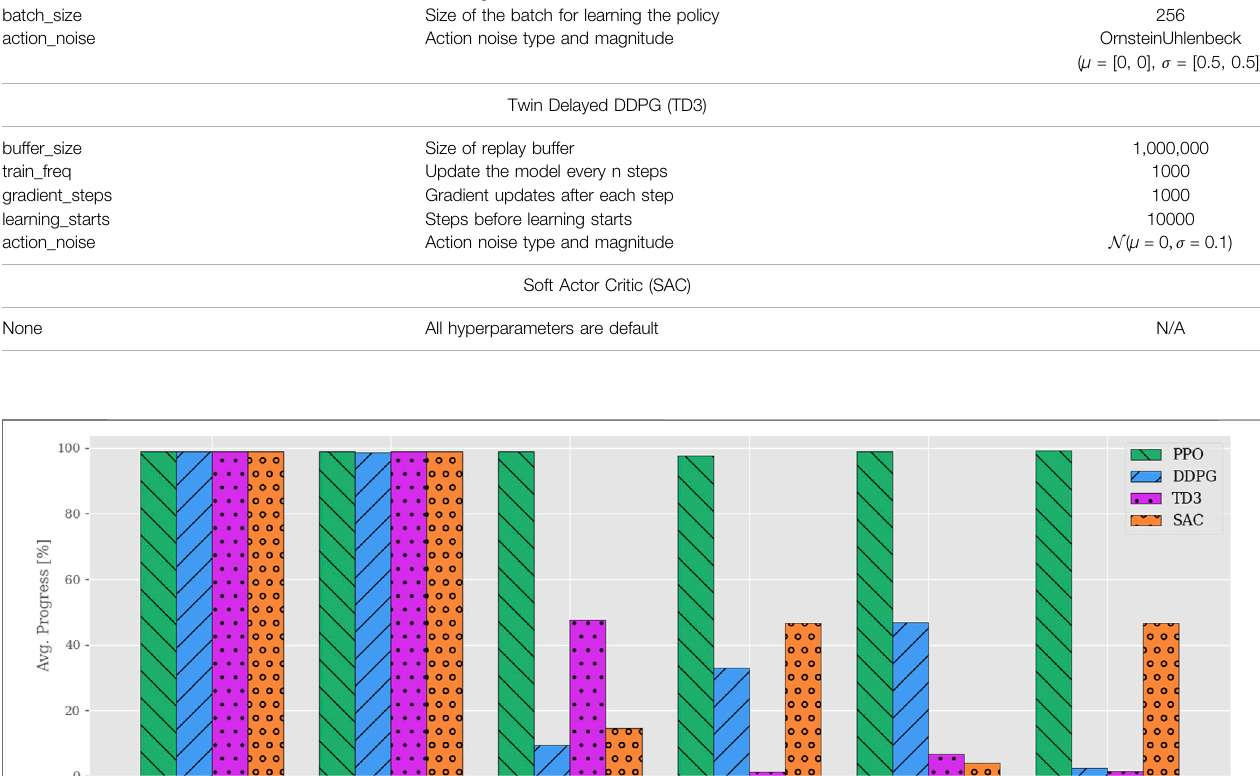
Frontiers in Robotics and AI |